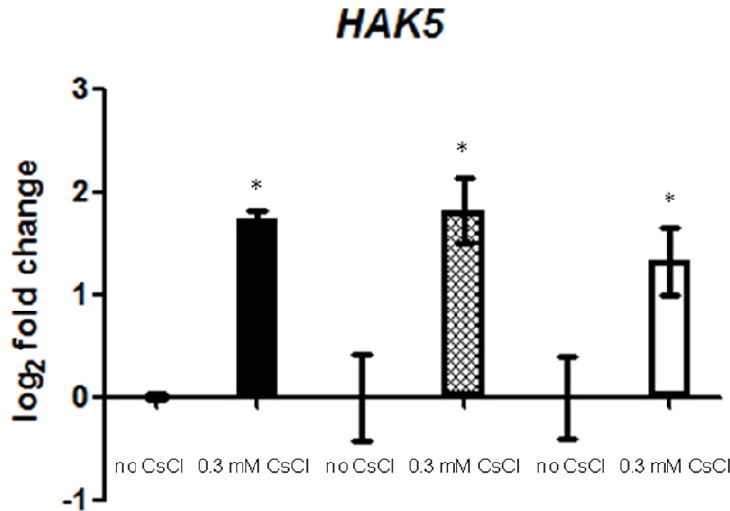
Figure 4. Gene expression of HAK5 in Col-0 (black bar), aos (crisscross bar) and coi1 -16 (white bar) grown on 1.75 mM KCl with or without 0.3 mM CsCl for seven days. Values are log ratios relative to the controls. Error bars indicate standard error for three technical 2 replicates. Each sample contained more than 15 seedlings, and the experiment was repeated three times, one of which is presented. Statistically significant differences ( p < 0.05) compared to each non-treated sample are indicated as asterisks.